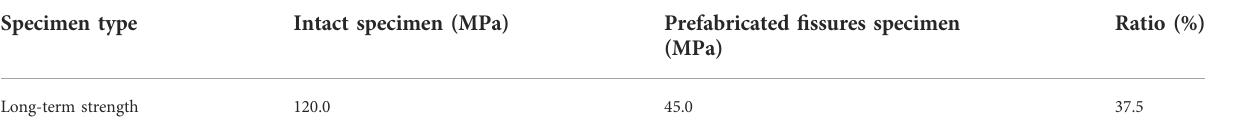
TABLE 3 Long-term strength of specimens.